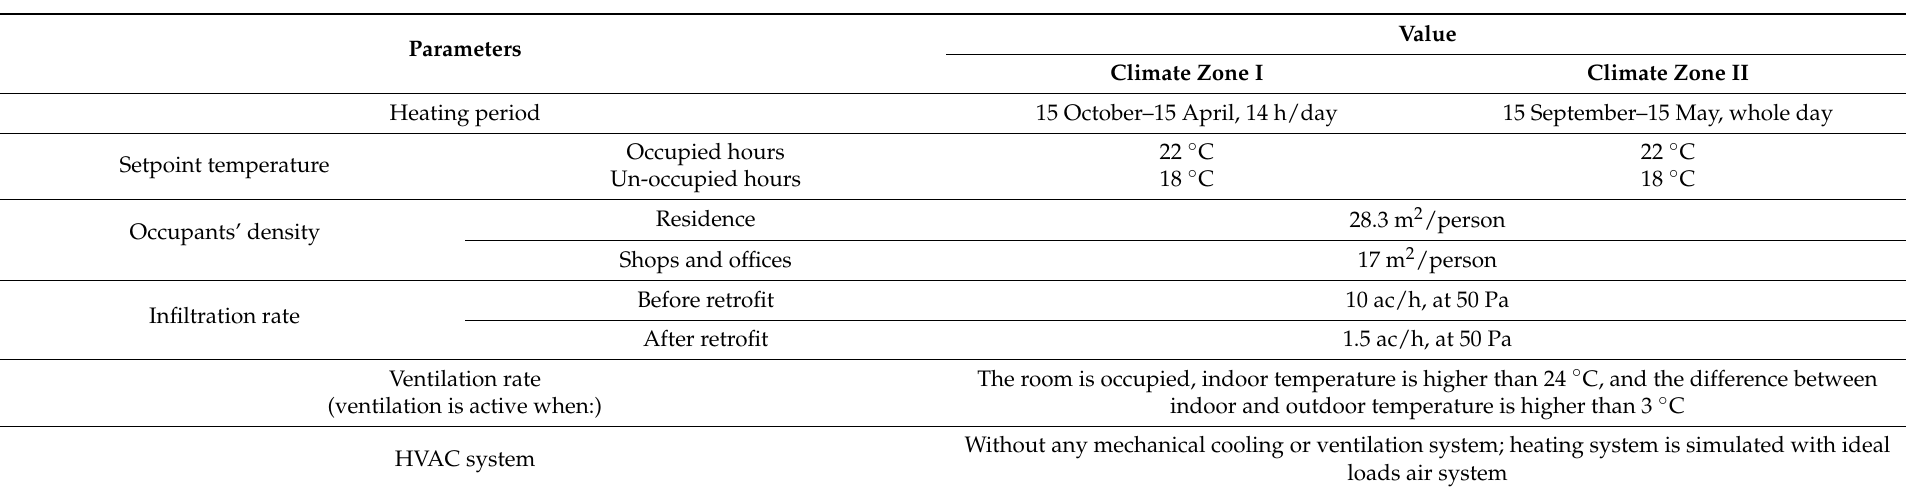
Figure 6. Occupancy profiles of living area ( a ) and commercial area ( b ) in the Portici houses. Table 5. Assumptions and variables used for the simulations.